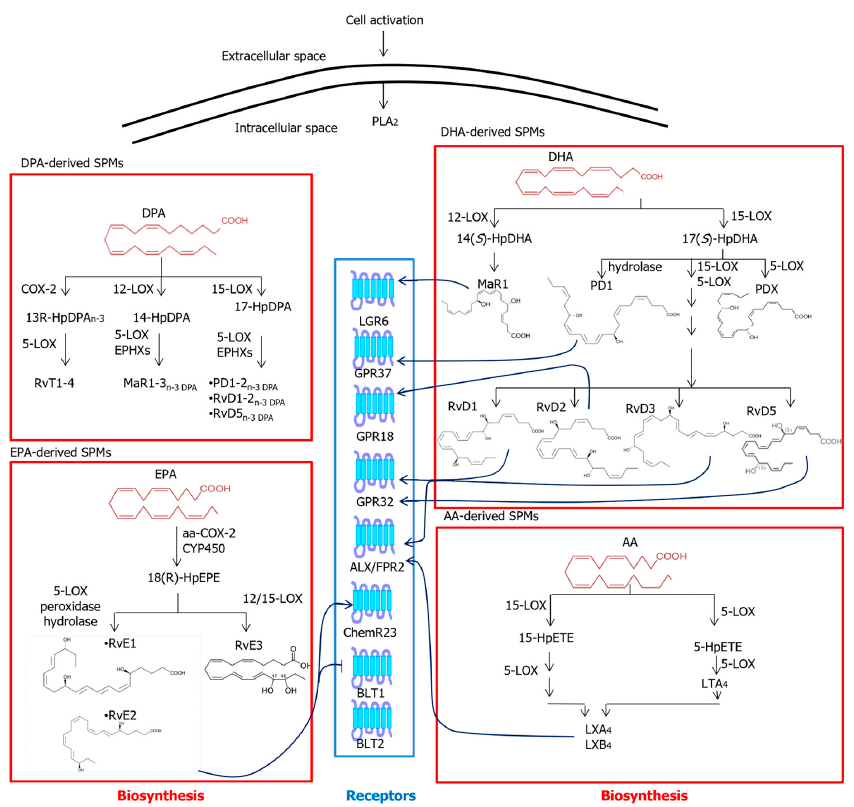
Figure 3. Metabolic pathways and known receptors of SPMs. Abbreviations: AA—arachidonic acid; ALX/FPR2—formyl peptide receptor 2; BLT—leukotriene B 4 receptor; ChemR23—chemerin recep-